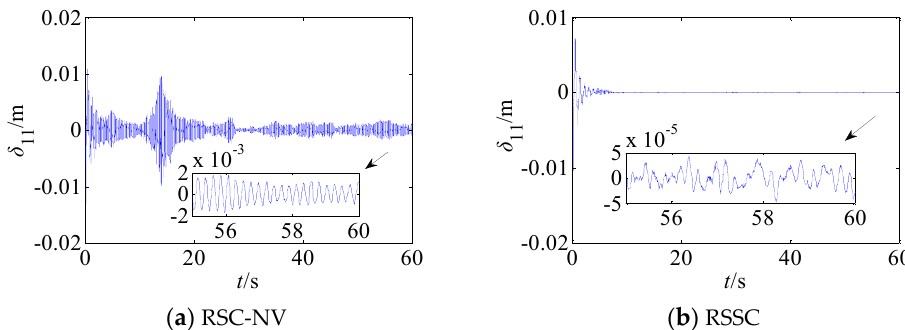
Figure 8. The first mode coordinates of the flexible link B 1 .